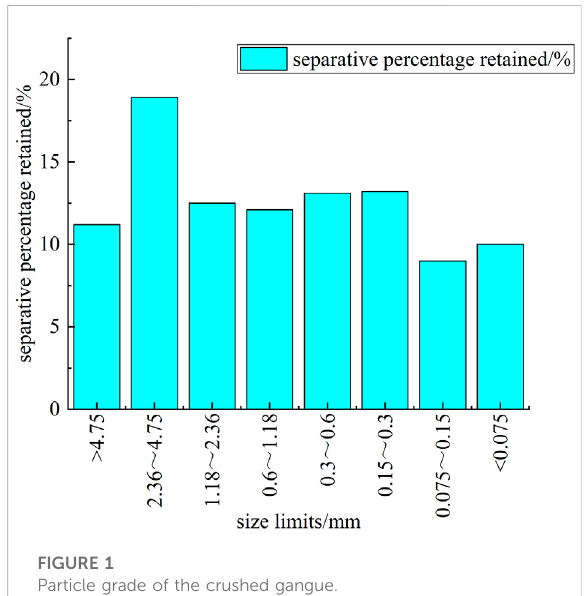
FIGURE 1 Particle grade of the crushed